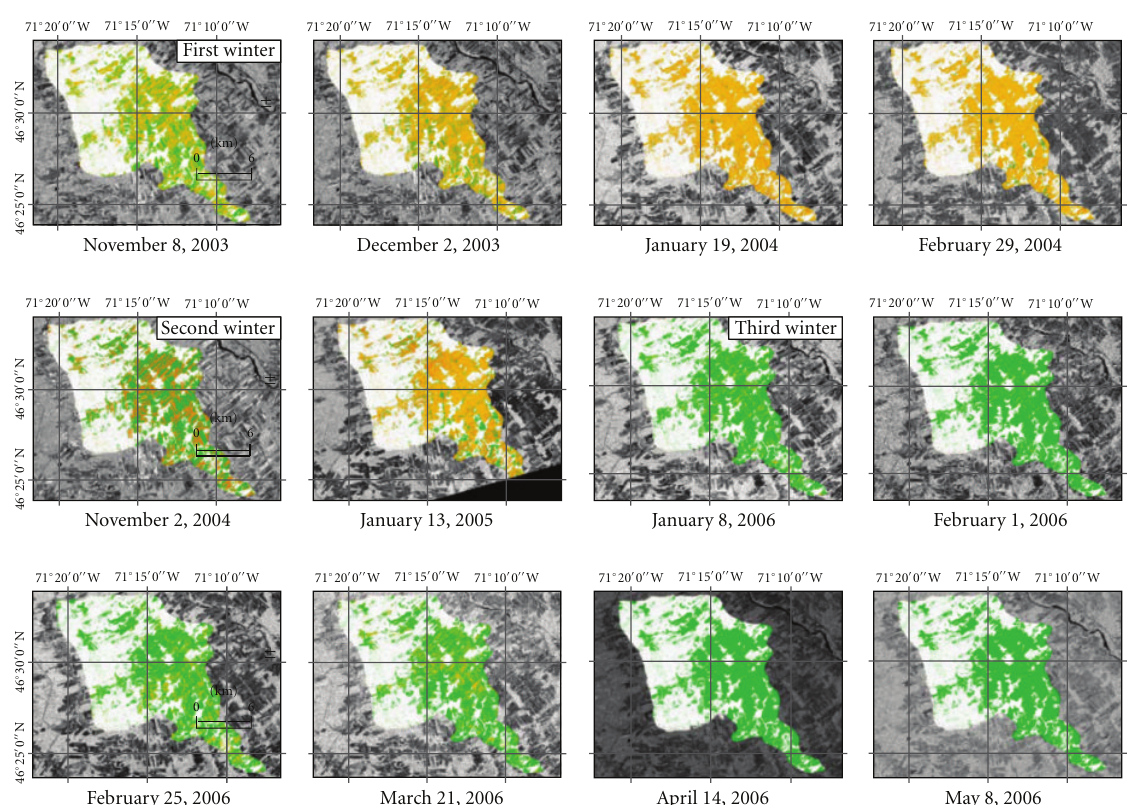
Figure 7: Maps of the frozen/unfrozen soil conditions in the Bras d’Henri watershed (2003–2006) using 12 RADARSAT-1 SAR images. Green: unfrozen soils, orange: tilled frozen soils, yellow: untilled frozen soils, and white: mask applied for forest area.